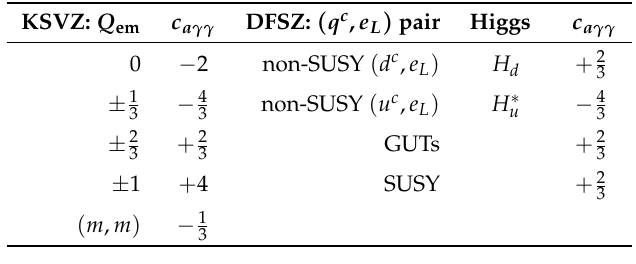
2sin 2 θ W ) / sin 2 θ W with −